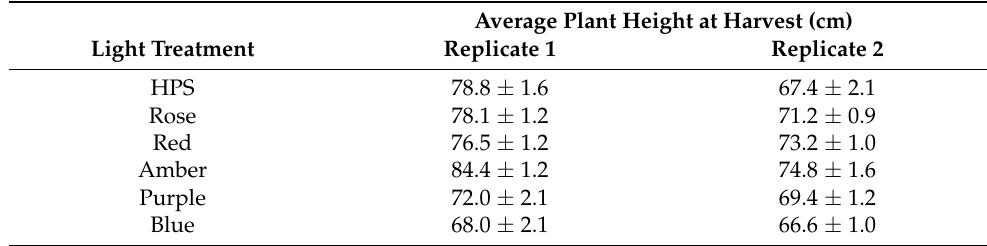
Table 1. Average final plant height per light treatment per replicate. Values are shown as mean ± SE ( n = 9). A significant difference was observed between replicates ( p < 0.0001). Treatments are high-pressure sodium (HPS), Blue (430 nm), Red (630 nm), Rose (430 + 630 nm, B:R ratio 1:10), Purple (430 + 630 nm, B:R ratio 2:1), and Amber (595 nm). Average Plant Height at Harvest (cm) Light Treatment